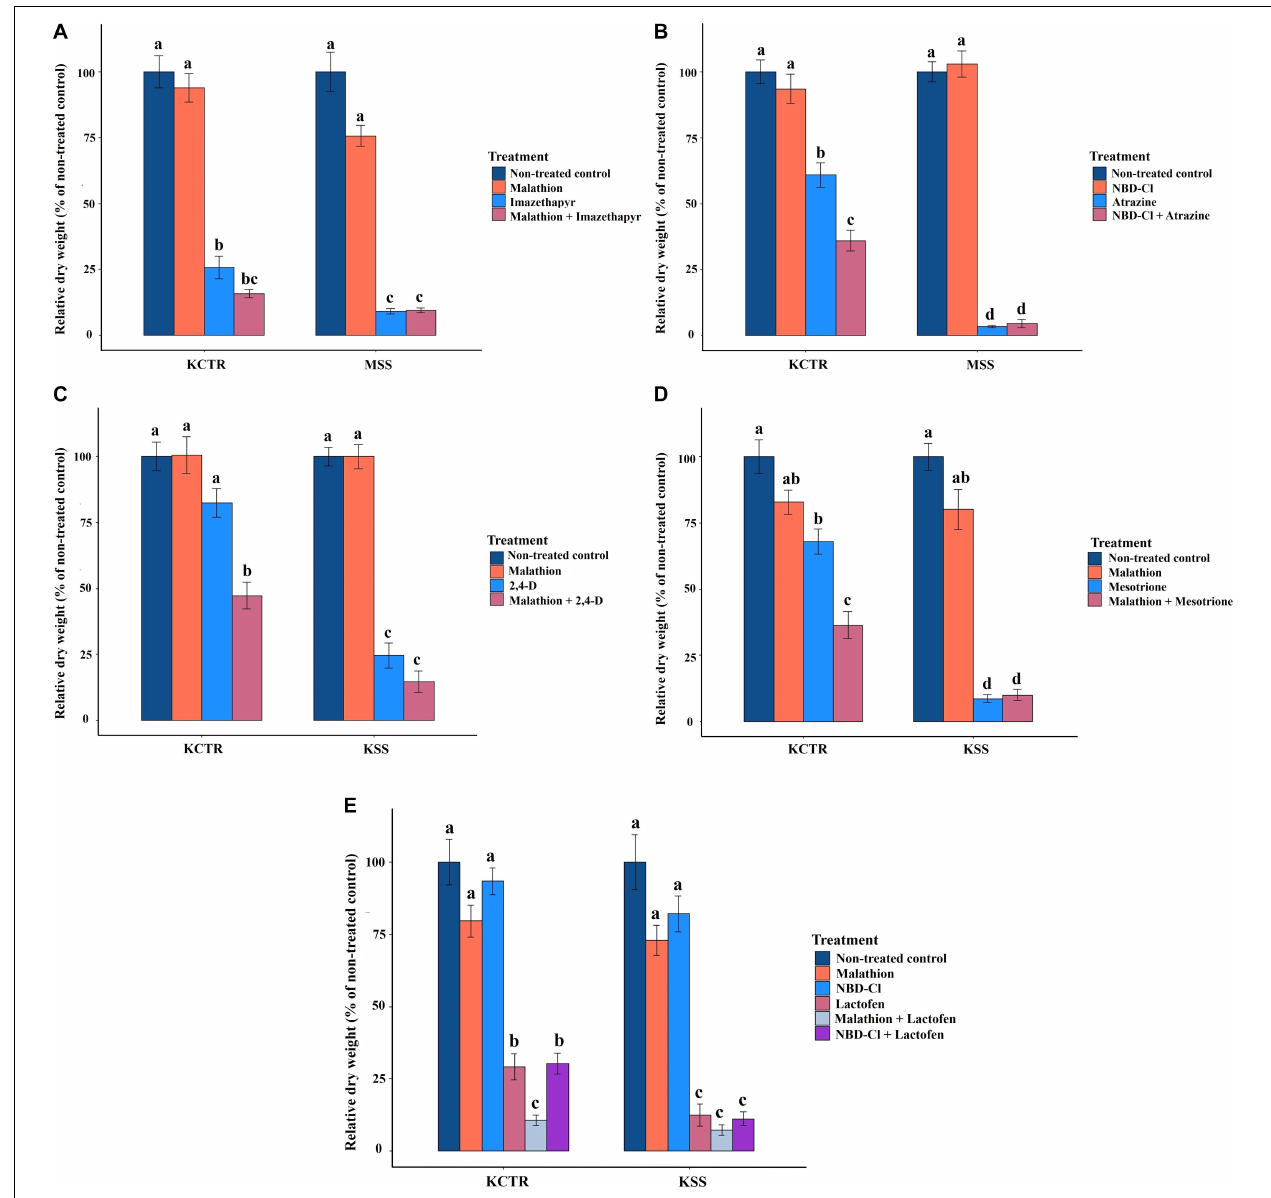
FIGURE 5 | Effect of P450 and GST inhibitors on efficacy of imazethapyr (A) , atrazine (B) , 2,4-D (C) , mesotrione (D) , and lactofen (E) in susceptible (KSS or MSS) and resistant (KCTR) Palmer amaranth populations. Error bars represent standard error of the mean. Letters represent significant differences identified by separation of means using Tukey